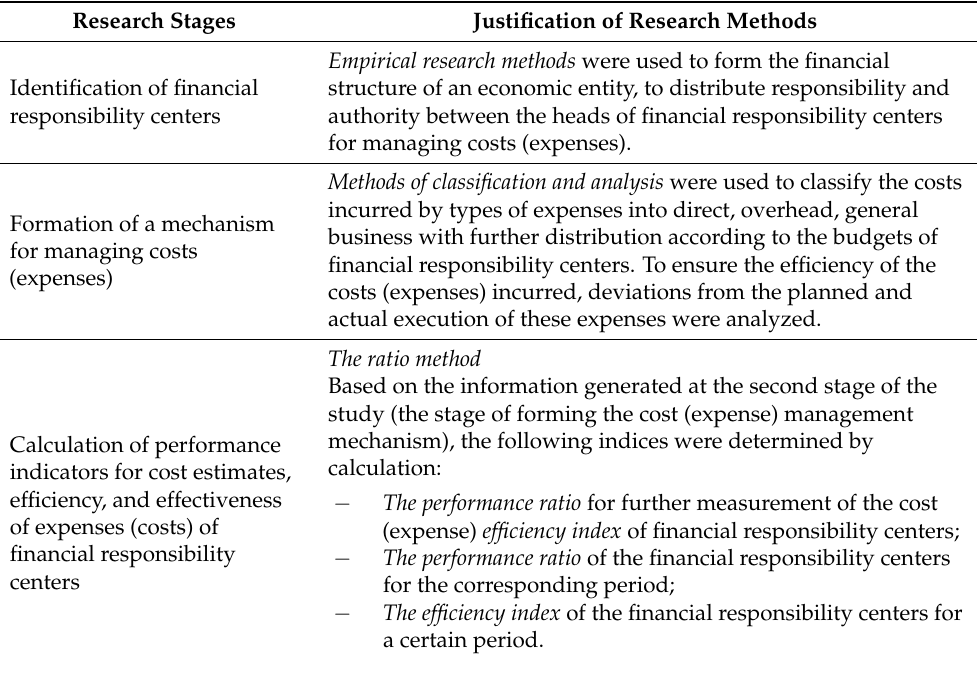
Table 1. Stages and methods of this